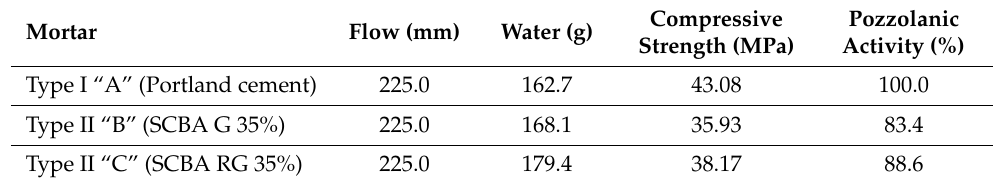
Table 3. Pozzolanic activity of